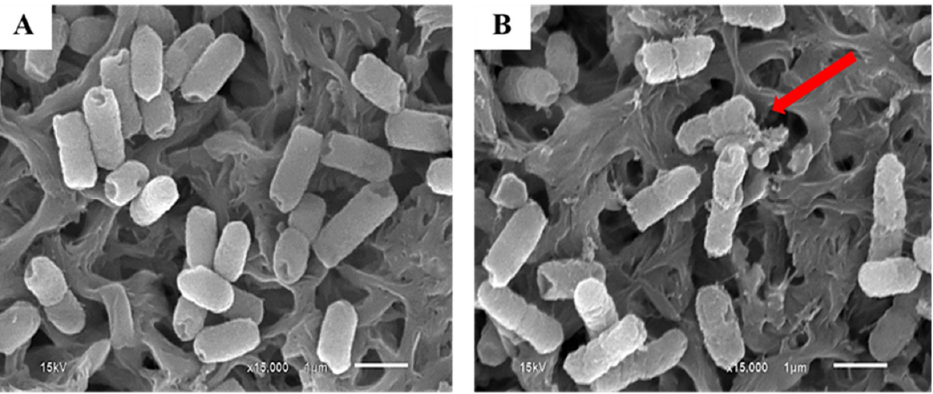
Figure 7. SEM images of E. coli cells for ( A ) untreated PAW, and ( B ) treated by PAW. Arrow indicates the rapture of E. coli cells after PAW treatment.